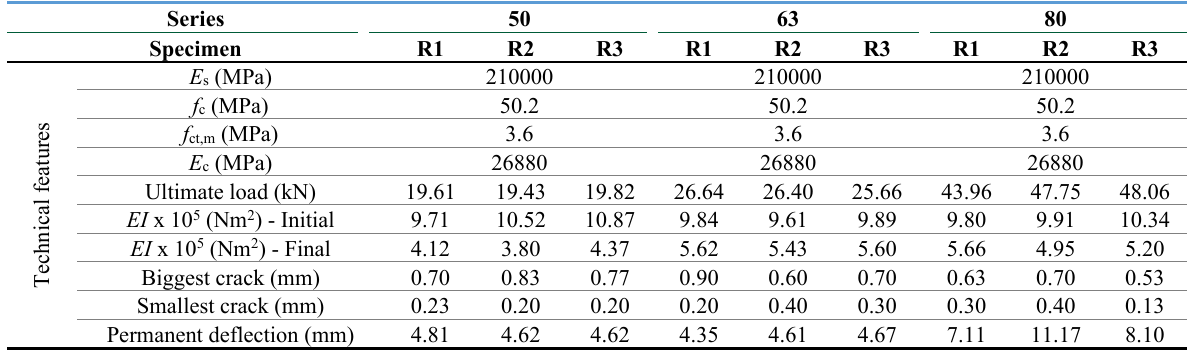
Table 1. Specimen